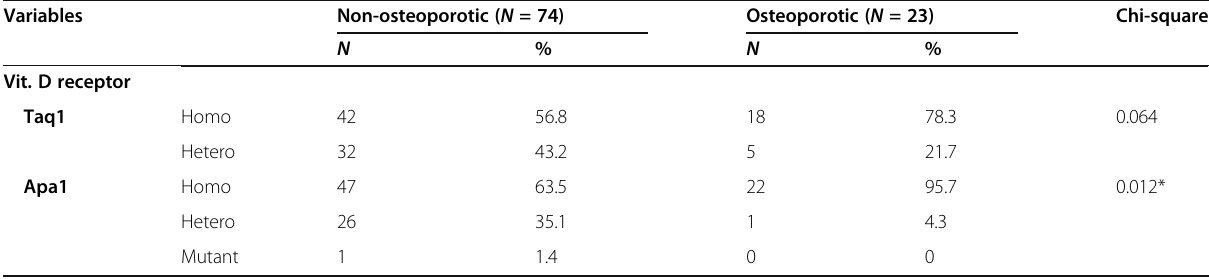
Mutant 1 N.B. * P < 0.05 = significant